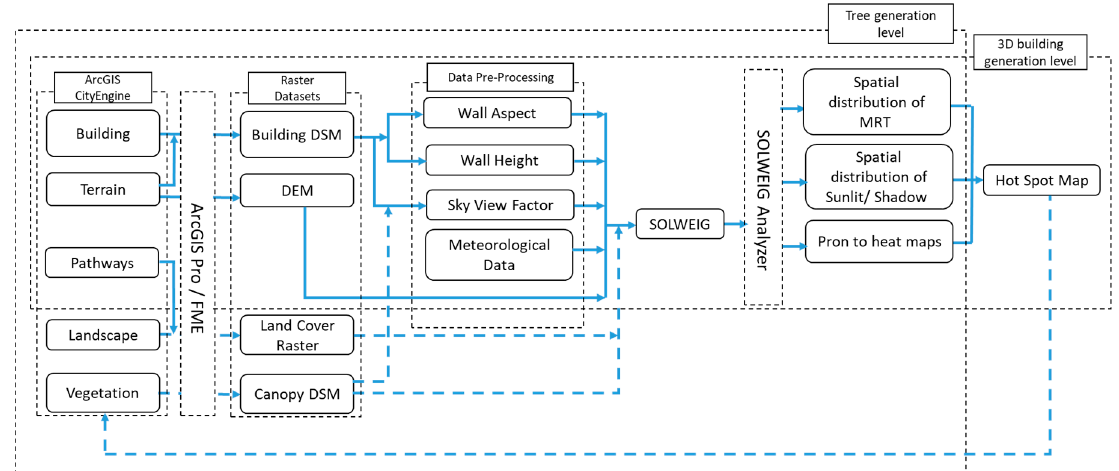
Figure 7. The detailed flowchart of data preparation and processing for hot spot map and vegetation Figure7. planning.